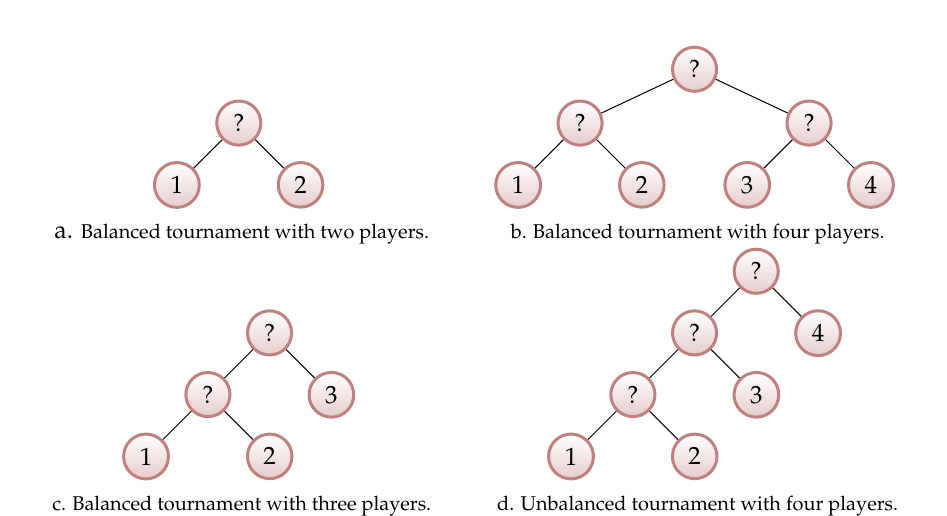
Figure 1. Tournaments of two and three players (first column) and four players (second